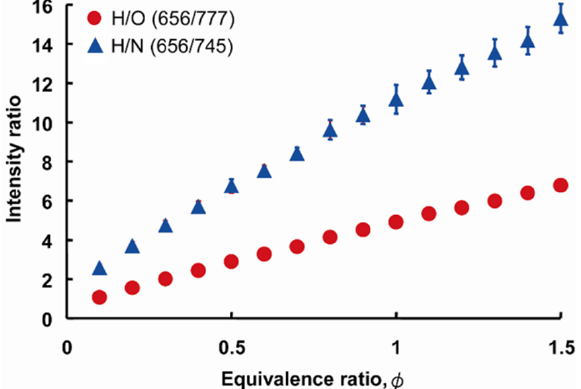
Figure 6. The intensity ratio of H/O and H/N in relation to the equivalence ratio of the propane–air mixture. Both intensity ratios increased with a higher equivalence ratio.